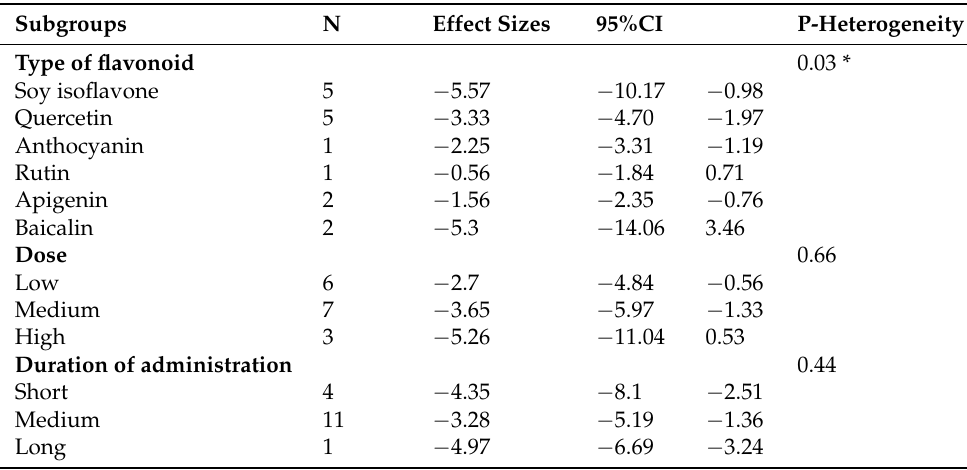
Table 6. Subgroup analysis of flavonoids effect on free